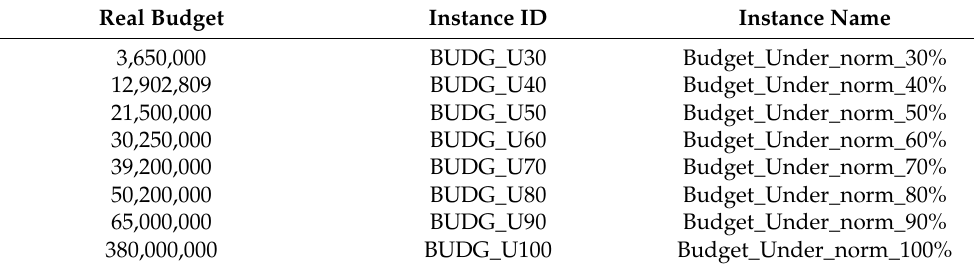
Table A1. Categorization criteria of “Budget” class in the experiment.